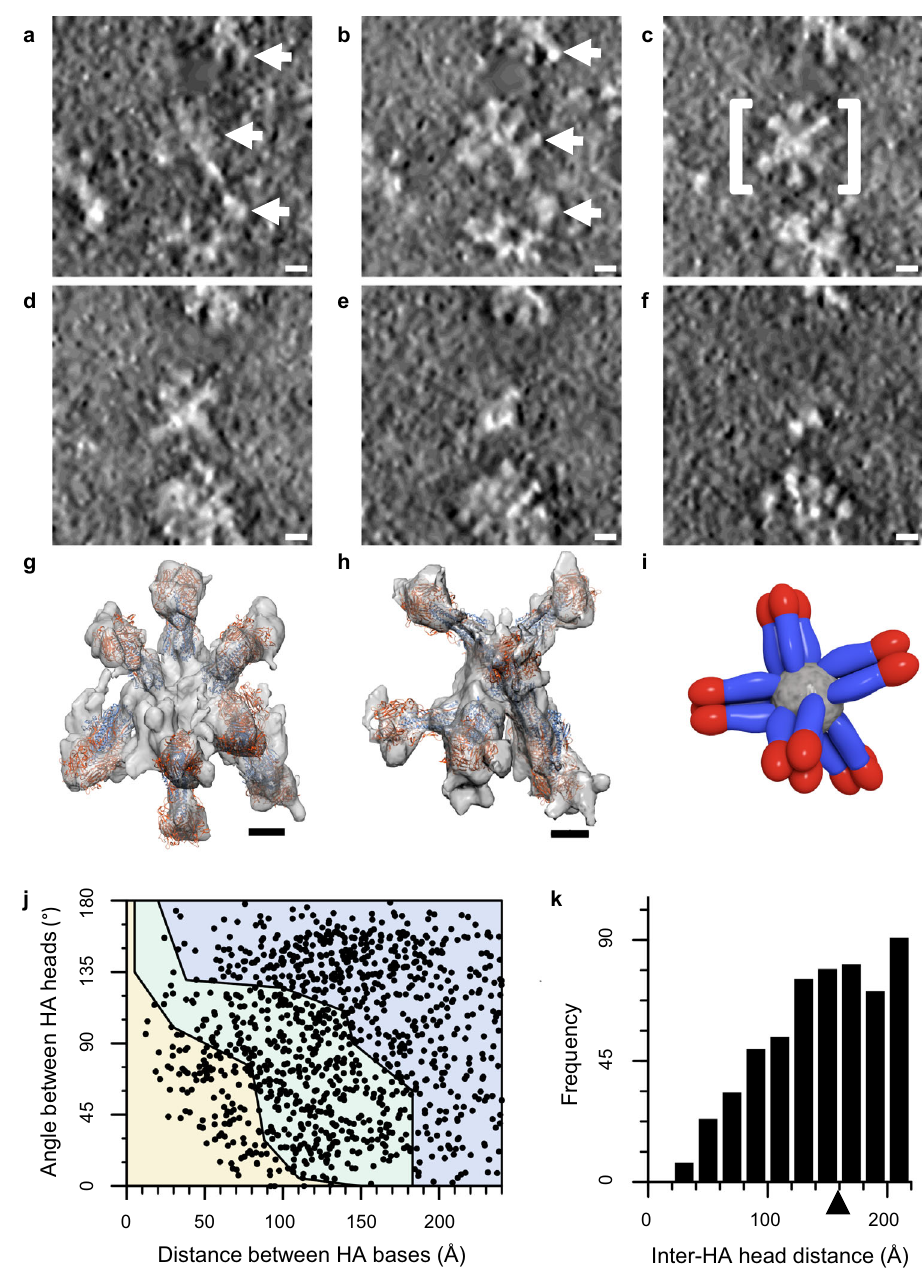
Fig.3|Flublokstructuralanalysisbycryo-electrontomographyandmolecular modeling. a – f Example of six serial slices from top to bottom of a cryo-electron tomogram with a fi eld of HAcomplexes. a , b White arrows indicate the location of three individual star fi sh complexes made of constituent HA molecules. c View in which the slice of the central complex (white brackets) presents a star fi sh arrangement of its HA molecules. g – h Two different molecular models of speci fi c complexes with trimeric HA ectodomain coordinates, with red denoting the head and bluedenoting the stem,dockedinto the 3D tomogramshownasatransparent isosurface. i A schematic of a HA-star fi sh structure illustrates how a central hydrophobic core (gray) contains HA transmembrane domains and lipid, and HA proteins point outward exposing the HA head colored in red, and the HA stem